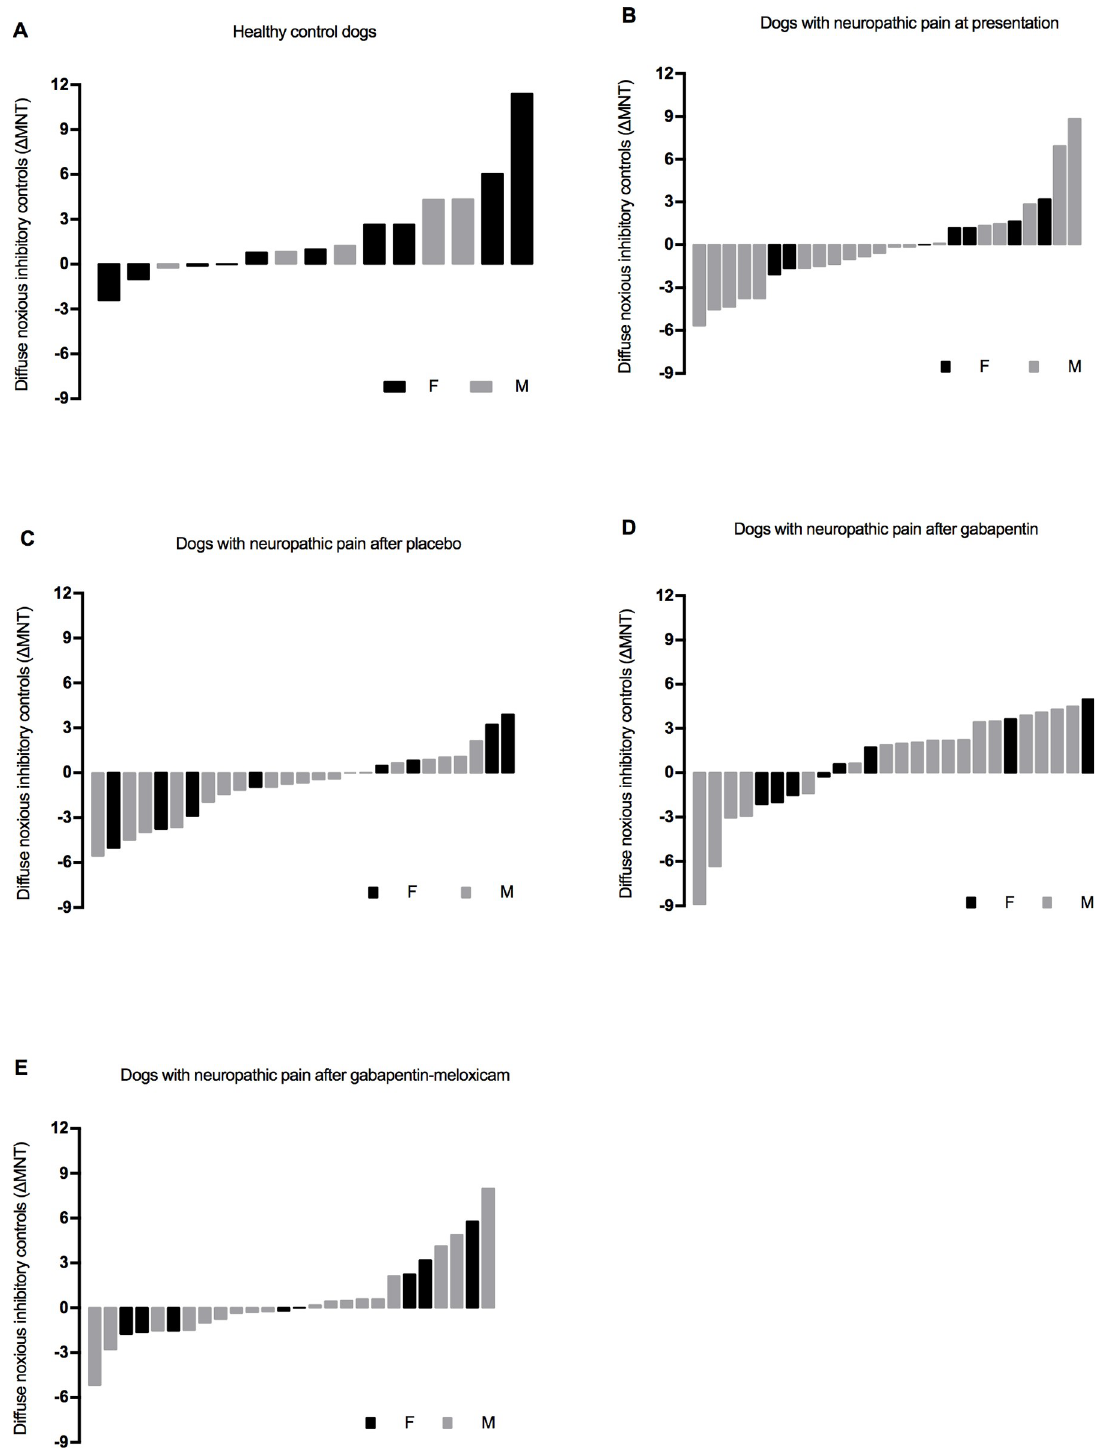
Fig 3. Diffuse Noxious Inhibitory Control (DNIC) in the population of a) healthy dogs, b) dogs with neuropathic pain at initial presentation, c) after placebo, d) after gabapentin-meloxicam and e) after gabapentin alone. Negative values represent facilitatory while positive values represent inhibitory conditioned pain